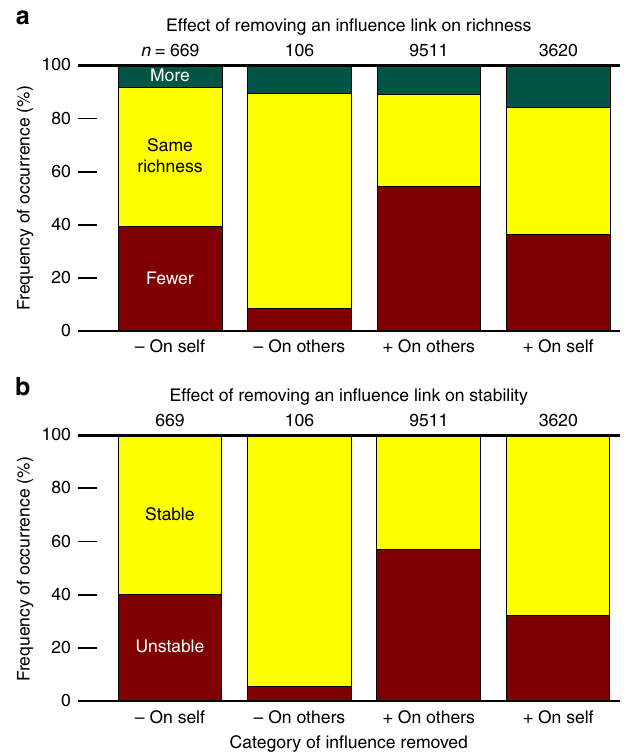
Fig. 5 Even individual in fl uences may causally impact coexistence and stability. In knock-out experiments we assess how removing an in fl uence link from the community impacts coexistence. In ( a ), the in fl uence is removed from the initial pool to ask how enrichment might be affected. Removing facilitation links has a considerable adverse effect on coexistence (with a large fraction of cases showing a drop in fi nal richness). In contrast, removing self-restraint has a modest in fl uence on coexistence, and removing inhibition of others on average bene fi ts coexistence. In ( b ), the in fl uence was removed from the fi nal community to see how an already stably coexistent community was affected by removal of different types of links. Observations in ( b ) match the trends in ( a ). Removal of facilitation likely disrupts the stable community, whereas removal of inhibition of others is unlikely to impact the community. Self-restraint interactions are at intermediate importance; their removal has a modest (~17%) chance of disrupting an already stable community in this example. Here, the initial pool has a binomial network with equally likely positive or negative in fl uences ( + : − = 50%:50%). Since examined in fl uences are chosen from derived communities that exhibited coexistence, more facilitative in fl uences are present (e.g., Fig. 4) and thus tested ( n = 13,131) than